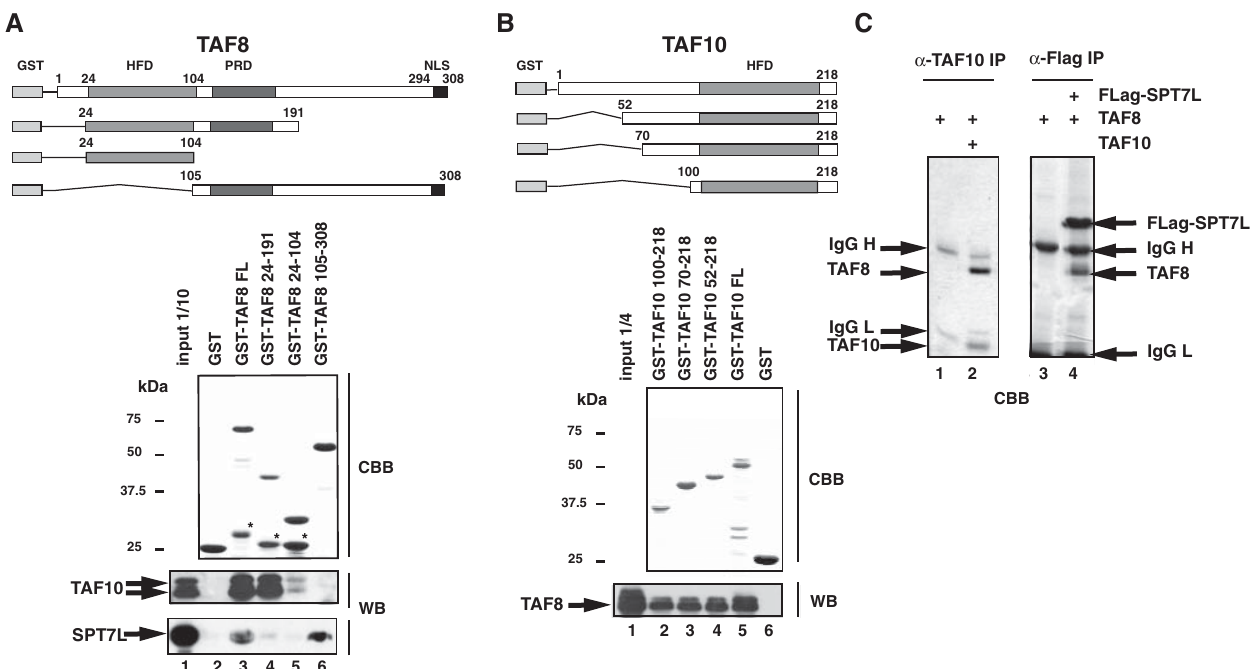
Figure 2. TAF8 interacts with TAF10 through its HF domain, while it interacts with SPT7L through its C-terminal region. GST-TAF8 (A) and GST- TAF10 (B) full length (FL) or the corresponding deletion mutants were immobilised on glutathion-sepharose beads (as indicated), washed and the bound GST-fusion proteins were separated by SDS-PAGE and visualized by Coomassie brilliant blue staining (CBB). (*) labels premature termination products. Equal amounts of the indicated baculovirus infected Sf9 whole cell extracts (WCEs) were incubated with each resin, washed and the bound proteins analysed by western blot (WB). The positions of molecular weight markers are indicated in kDa. HFD: histone fold domain; PRD: proline rich domain; NLS: nuclear localization signal. (C) TAF8 was expressed alone (lane 1 and 3), coexpressed with TAF10 (lane 2) or with Flag-SPT7L (lane 4) in Sf9 cells using the baculovirus system. From these cells WCEs were prepared and proteins immunoprecipitated with the indicated antibodies. Bound proteins were separated by SDS-PAGE and visualized by Coomassie brilliant blue staining (CBB). The co-immunoprecipitation between TAF8 and TAF10 as well as TAF8 and SPT7L indicates strong stoichiometric interactions between these proteins.